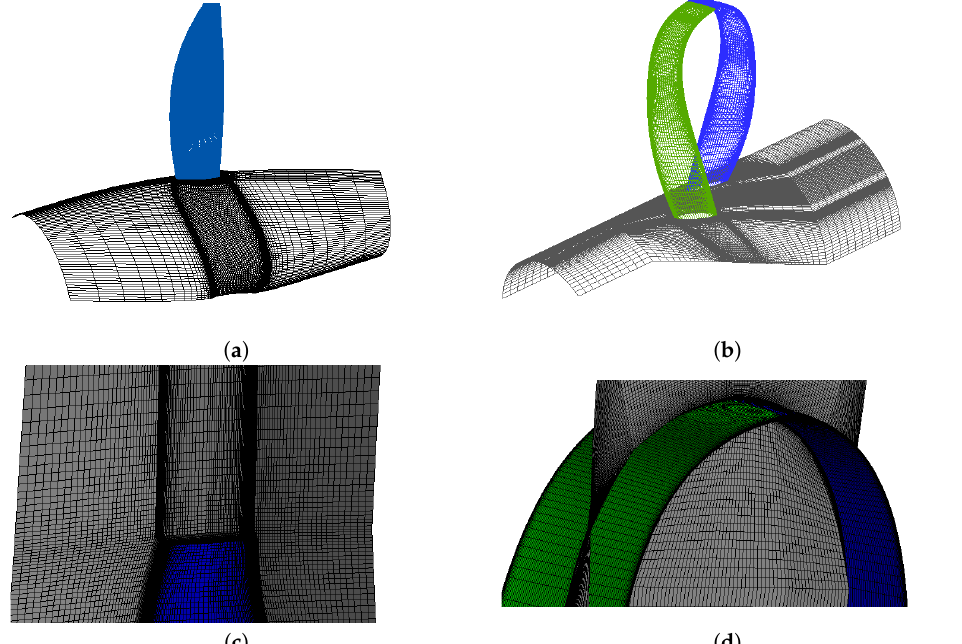
Figure 7. Surface cells of the meshes for ( a ) Conprop-6 and ( b ) Boxprop. Volume and surface cells near the blade tip for ( c ) Conprop-6 and ( d )